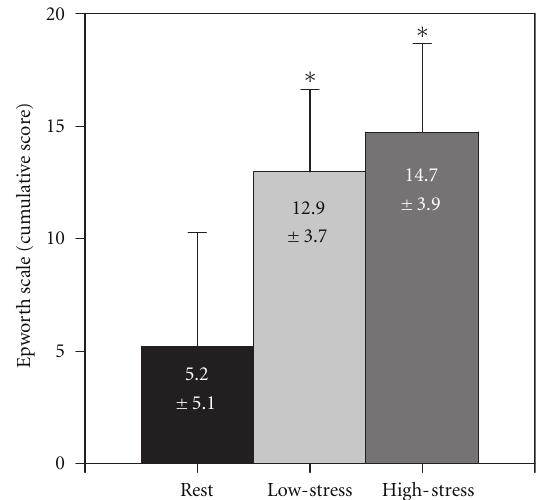
Figure 1:Dynamicsinsleepinessamongthe subjects. Data were an- alyzed with the Epworth Sleepiness Scale and presented as Mean ± SEM of cumulative score, n = 15. ∗ Statistically significant ( P < 0 . 05) di ff